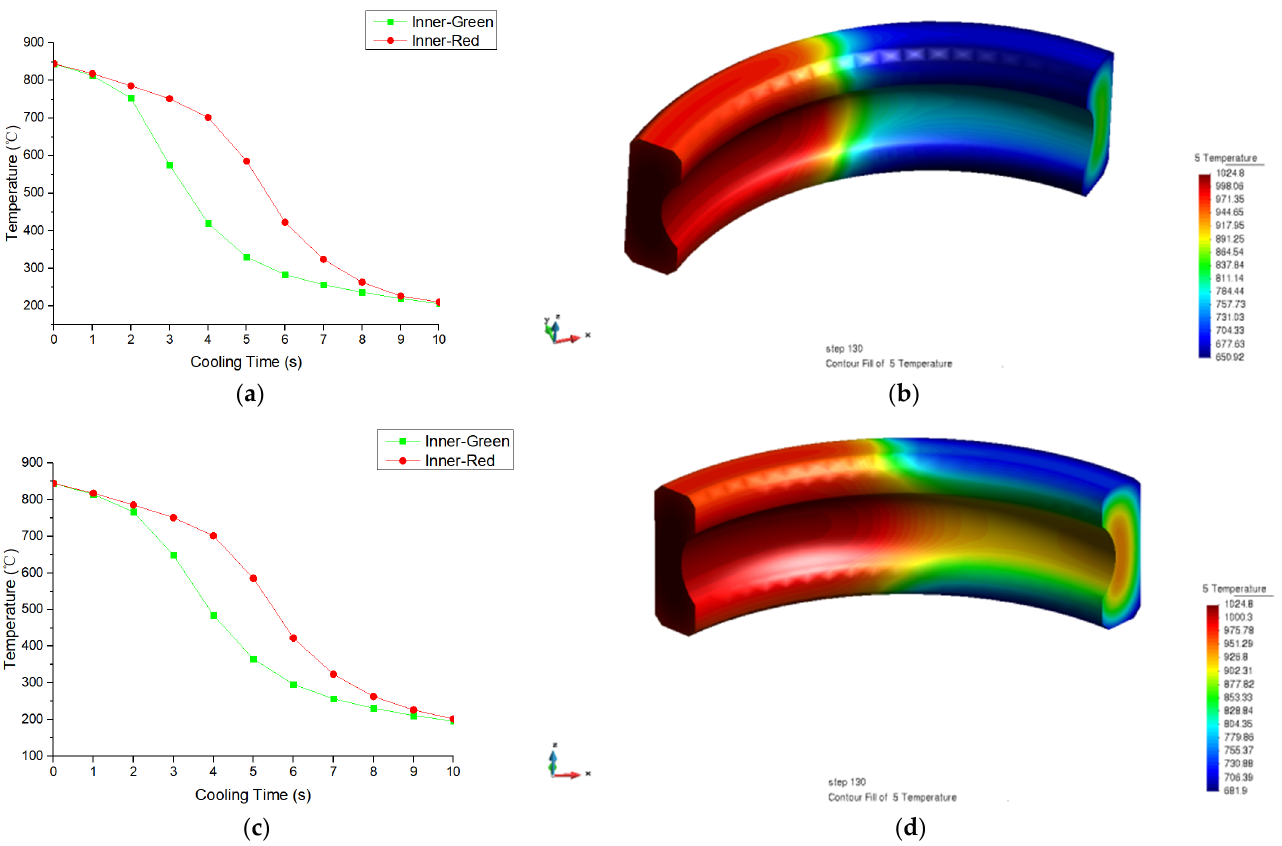
Figure 13. Analysis of the temperature field for orthogonal symmetrical heat transfer and external orthogonal symmetrical, internal axial symmetry heat transfer. ( a ) Cooling curve from center of the two sections for orthogonal symmetrical heat transfer; ( b ) temperature field plot for orthogonal symmetrical heat transfer at 3 s; ( c ) cooling curve from center of the two sections for external orthogonal symmetrical and internal axial symmetry heat transfer; ( d ) temperature field plot for external orthogonal symmetrical and internal axial symmetry heat transfer at 3 s.